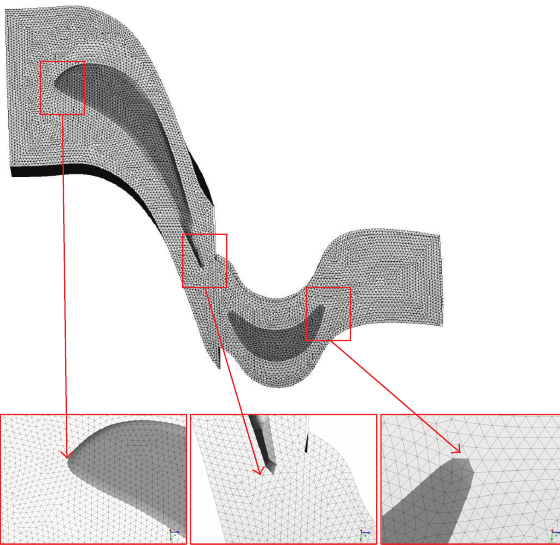
Figure 3: Passage mesh and zoom up of grids employed.